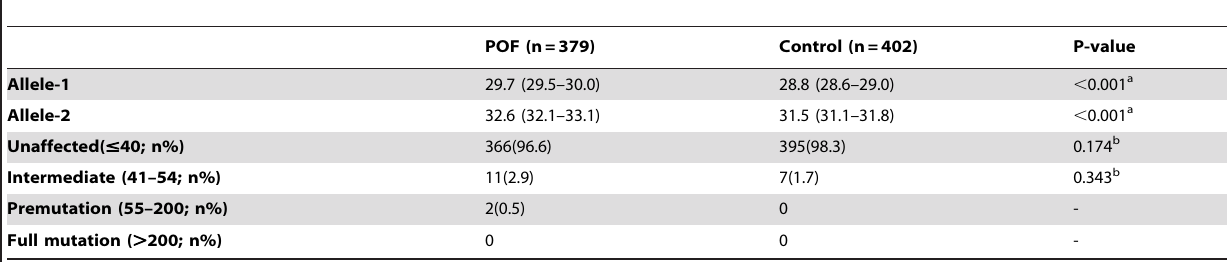
Table 3. Comparation of the CGG repeats on FMR1 gene between sporadic POF patients and normal control